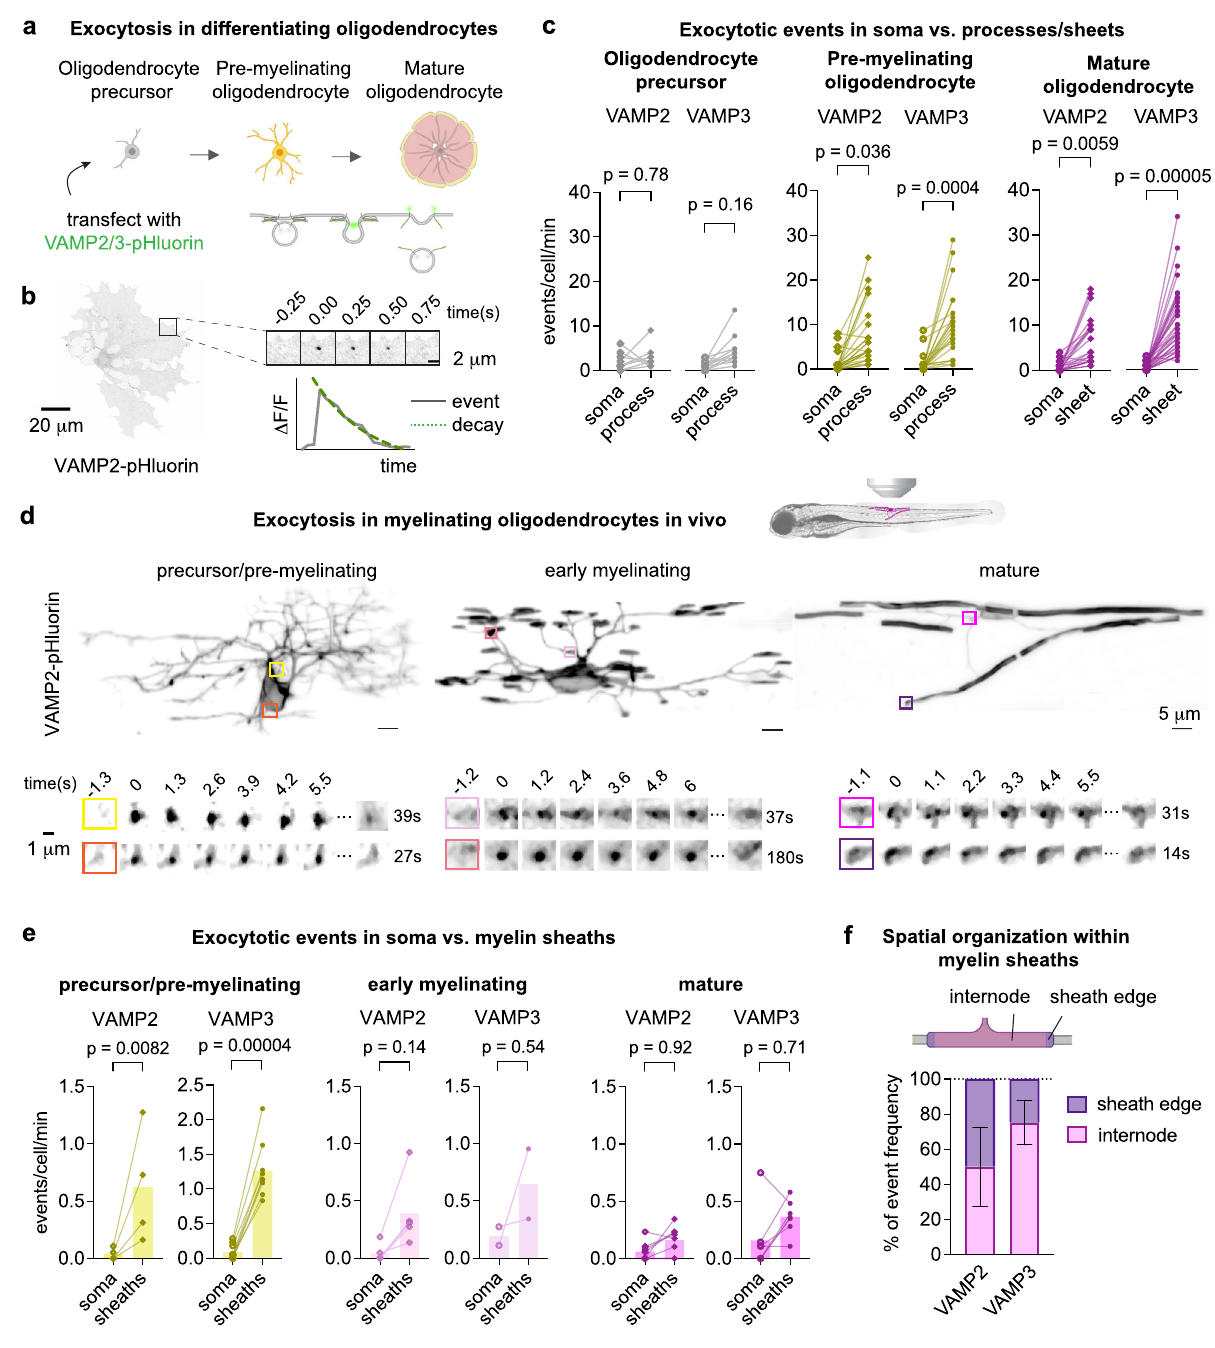
Fig. 2 | VAMP2/3-mediated exocytosis occurs preferentially in myelin sheaths. a Top: diagram depicting oligodendrocyte differentiation in culture; bottom: transfection of oligodendrocyte precursors with pHluorin-tagged VAMP2 or VAMP3 to visualize exocytosis. Created with BioRender.com. b Representative imageofapre-myelinatingoligodendrocyteexpressingVAMP2-pHluorin.Montage shows an exocytotic event over time, and the corresponding plot of intensity vs. time shows the characteristic fl uorescent increase and decay ( fi tted by the green dotted line). c Frequency of VAMP2- or VAMP3-pHluorin events localized to the somaortotheprocesses/sheetsincultured ratoligodendrocyteprecursors(gray), pre-myelinating (yellow), or mature oligodendrocytes (magenta). Each pair of pointsconnectedbyalineshowseventsforonecell.SeeSupplementaryTable1for average event frequencies±SEM. Statistical signi fi cance was determined using the mean of each biologically independent replicate ( n =3) by an ordinary one-way ANOVA withTukeycorrection formultiple comparisons. Sourcedata are provided